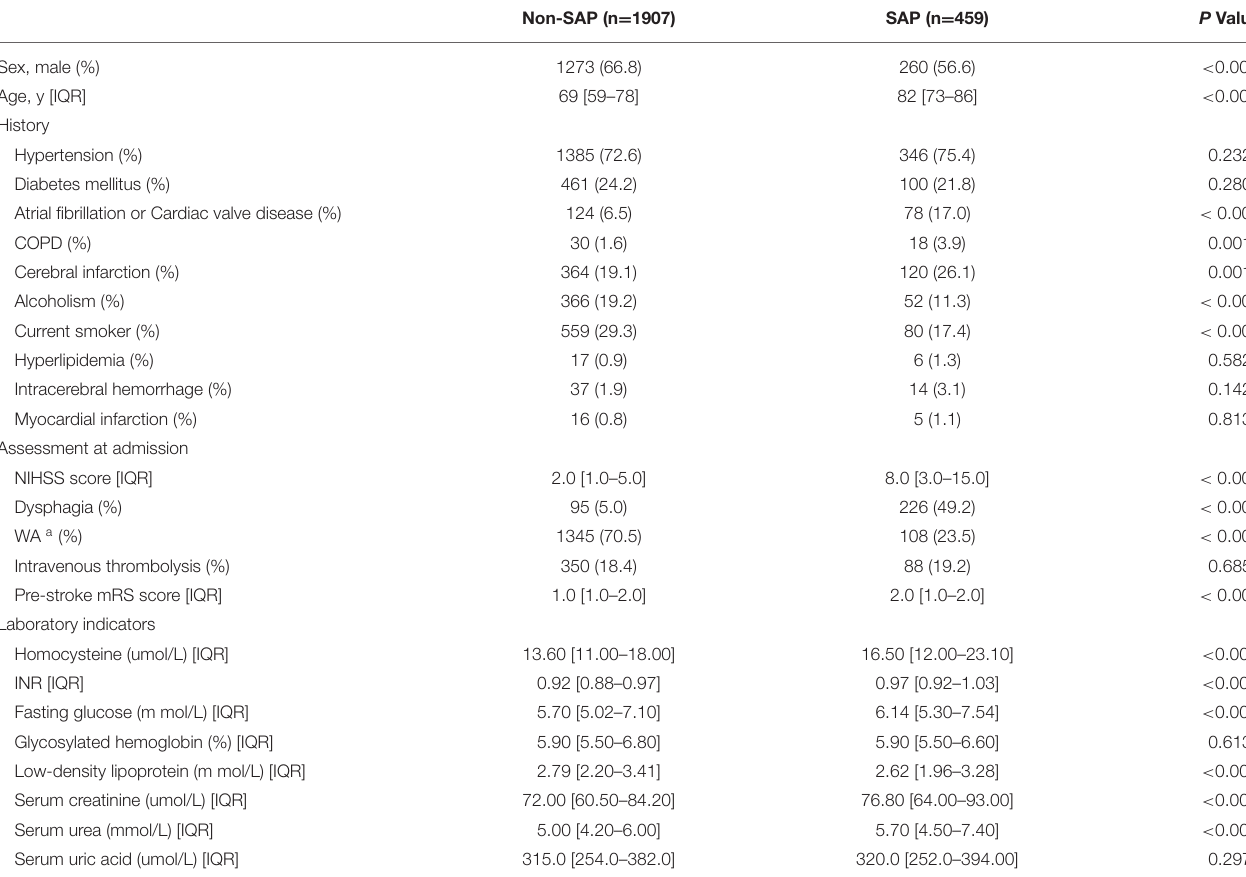
TABLE 1 | Baseline characteristics of patients with SAP and non-SAP with acute ischemic